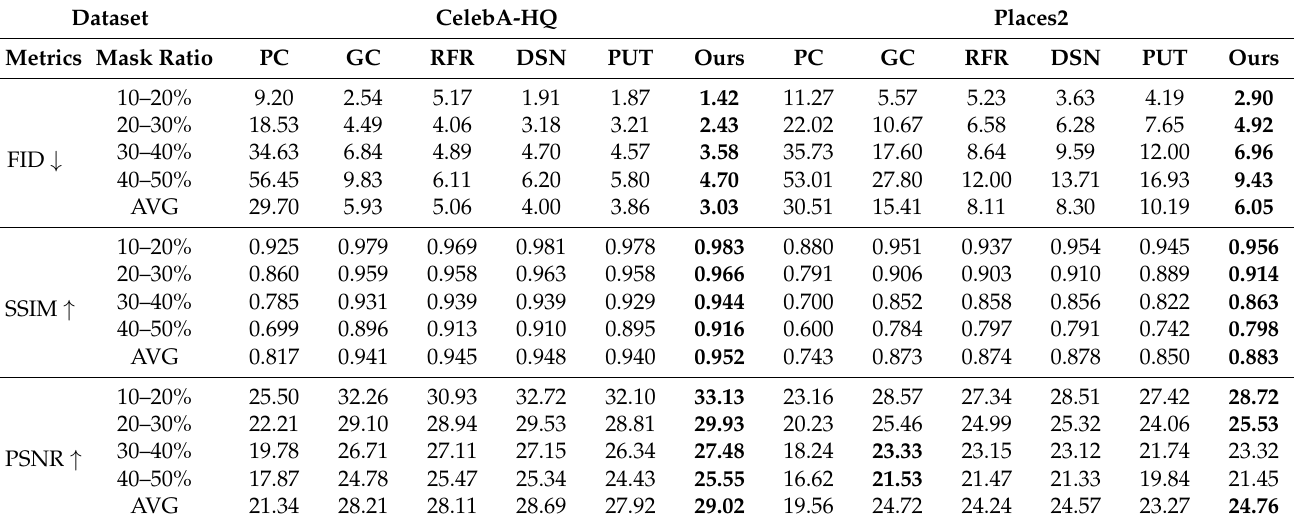
Table 3. Numerical comparison of the CelebA-HQ and Places2